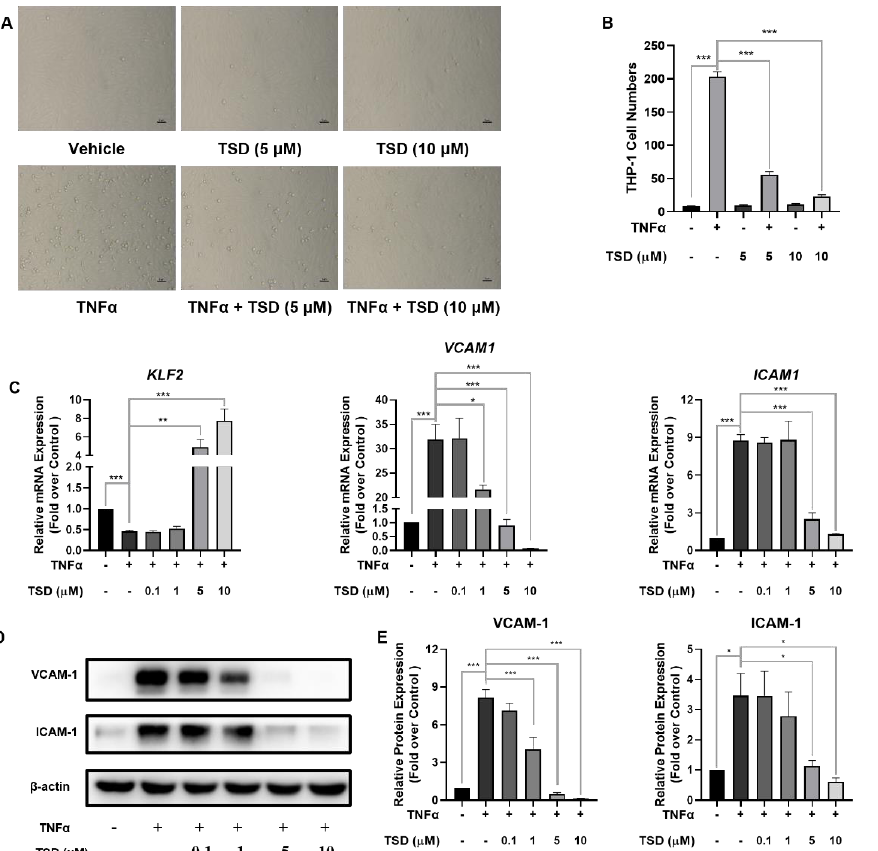
Figure 2. TSD attenuated monocyte adhesion to HUVECs. ( A , B ) Representative images ( A ) and quantification results ( B ) of monocyte adhesion to HUVECs after treatment with TSD. The cells were plated in 6-well plates and treated with TSD (5, 10 µ M) or DMSO for 18 h; then, tumor necrosis factor alpha (TNF α ) (10 ng/mL) was added to the cells for 6 h. THP-1 cells were co-incubated for another 30 min. Values are represented as the mean ± SEM; n = 3; one-way ANOVA was used for analysis. *** p < 0.0001. ( C – E ) mRNA expression ( C ), representative western blot ( D ), and quantification of protein expression of vascular cell adhesion protein 1 (VCAM-1) and intercellular adhesion molecule 1 (ICAM-1) ( E ) after treatment with TSD. The cells were plated in 6-well plates before treatment with TSD (0, 0.1, 1, 5, and 10 µ M) for 18 h. TNF α (10 ng/mL) was added to the cells for 6 h,